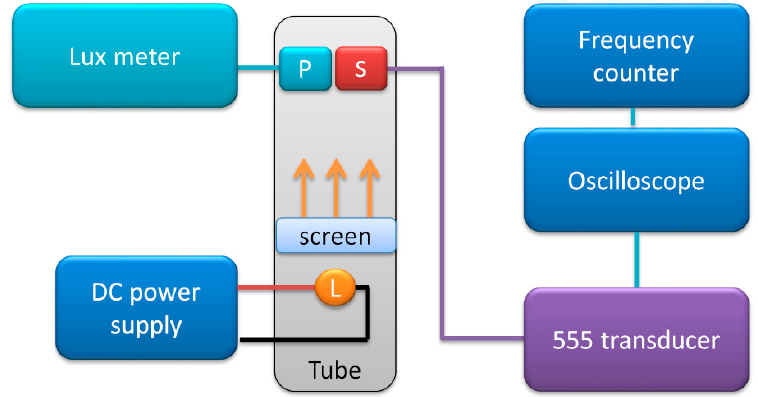
Figure 8. Schematic diagram of measurement test stand for resistive light sensor calibration.